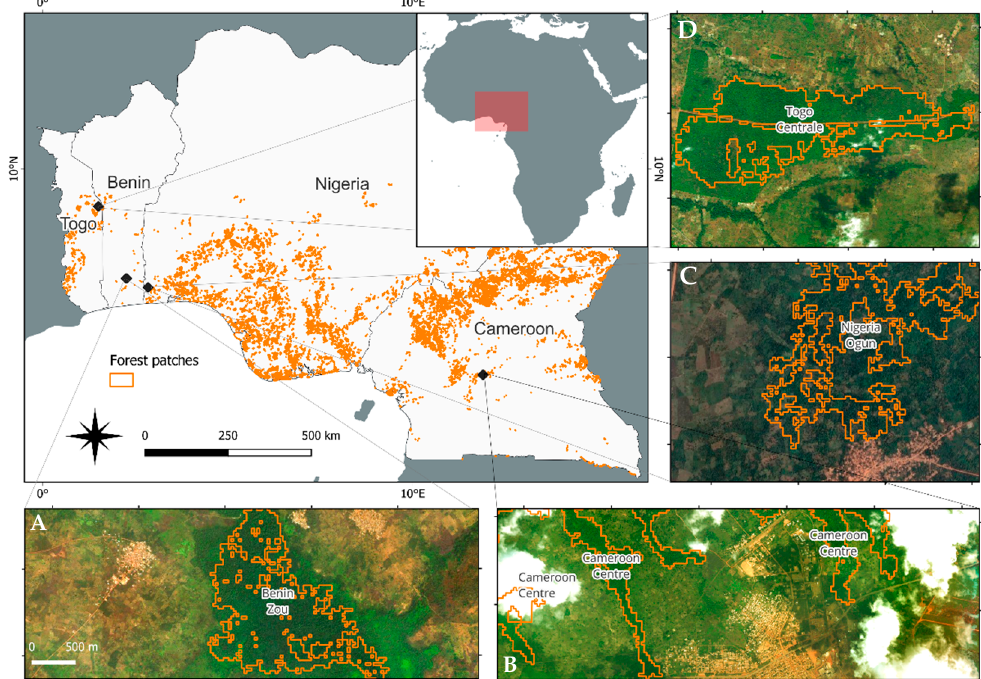
Figure 4. Figures showing forest patches samples; polygons outlined in orange are forest patches identified as fitting our proposed definition. Panel ( A ) sample near a village in southern Benin. Panel ( B ) sample near an urban and intensive agricultural area in central Cameroon. Panel ( C ) sample close to a highway and rural village in south-western Nigeria. Panel ( D ) sample in a smallholder arable mosaic in north-eastern Togo.